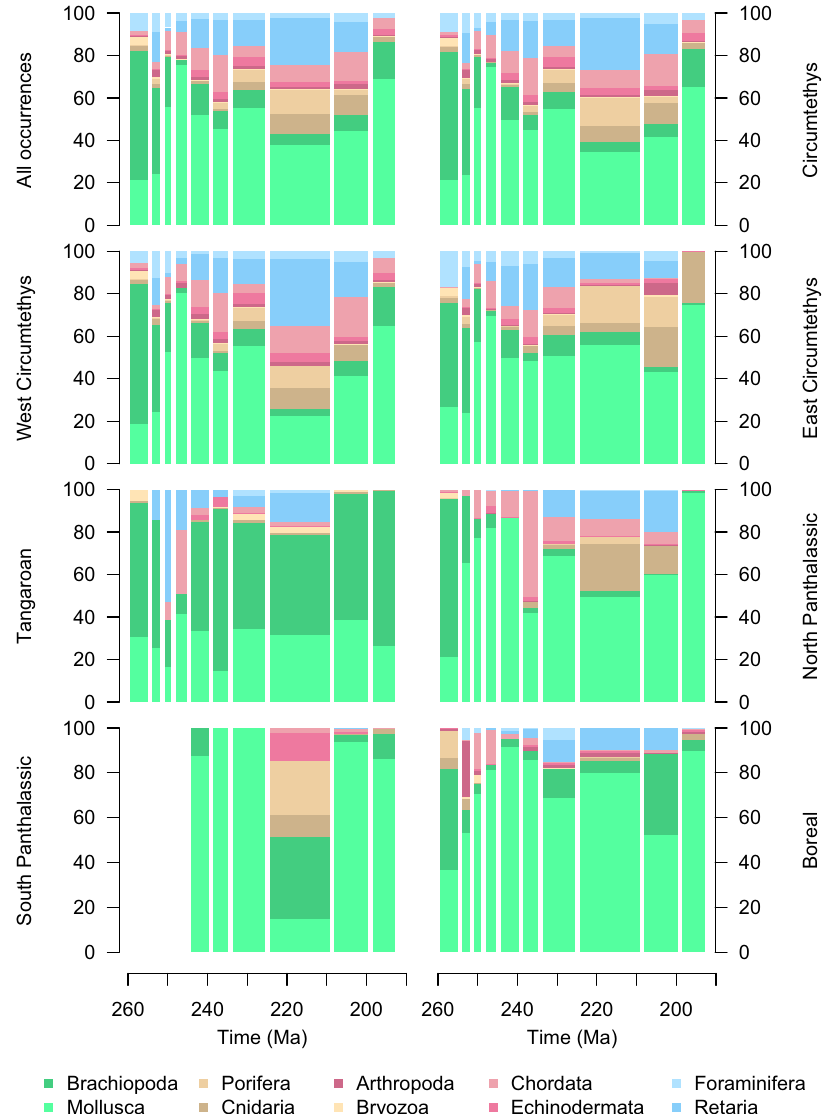
Fig. 7 Taxonomic compositions of the total dataset and each sampling region through the Late Permian to Early Jurassic (259.5 – 192.9 Ma). Comparison of the total dataset to the West Circumtethys dataset indicates the dominance of the latter within our analyses (see Fig. 5 also). The prevalence of cephalopods also indicates the potential for taphonomic bias with regard to the taxonomic af fi liations of the fossil occurrences, indicating that regional and even global views of diversity dynamics through our study interval will largely re fl ect the tempo of one or a handful of different clades. Source data are provided as a Source Data fi